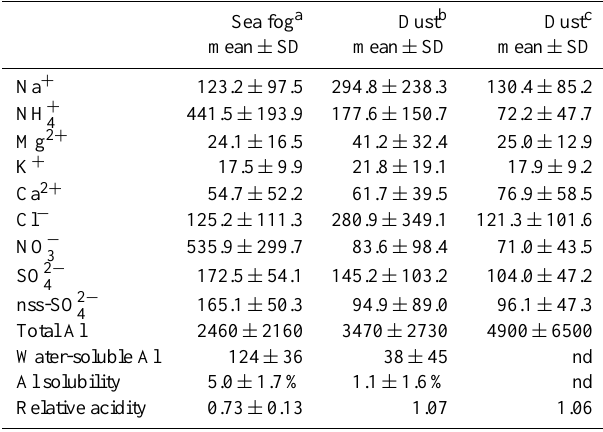
Table 2. Mean molar concentrations (nmolm − 3 ) of major ionic species together with Al (ngm − 3 ) in sea-fog-modified aerosols and dust aerosols in the ECS.